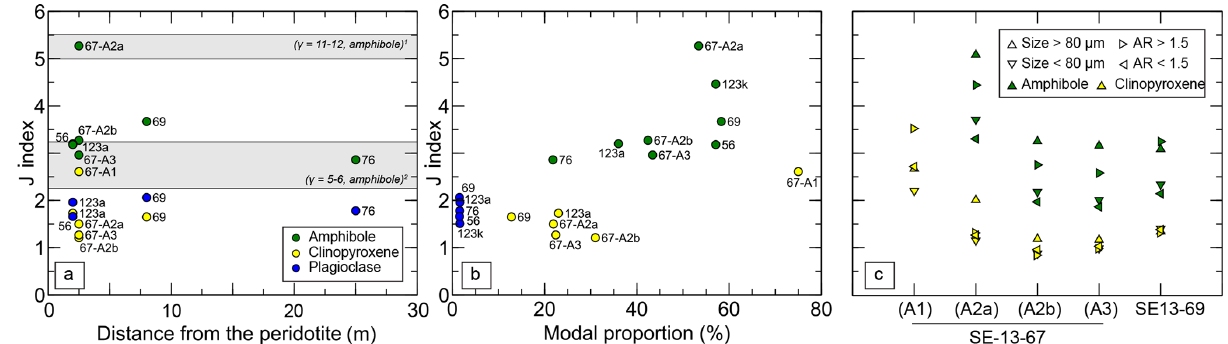
Figure 10. Quantified CPO strength (using the J index) of amphibole, clinopyroxene and plagioclase vs. (a) the distance from the contact with the peridotite and (b) the modal proportion of each phases from Sumeini, Khubakhib and Wadi Tayin localities (see Table 1); (c) the J index of amphibole and clinopyroxene as a function of their aspect ratio and grain size for the samples from the Sumeini cross